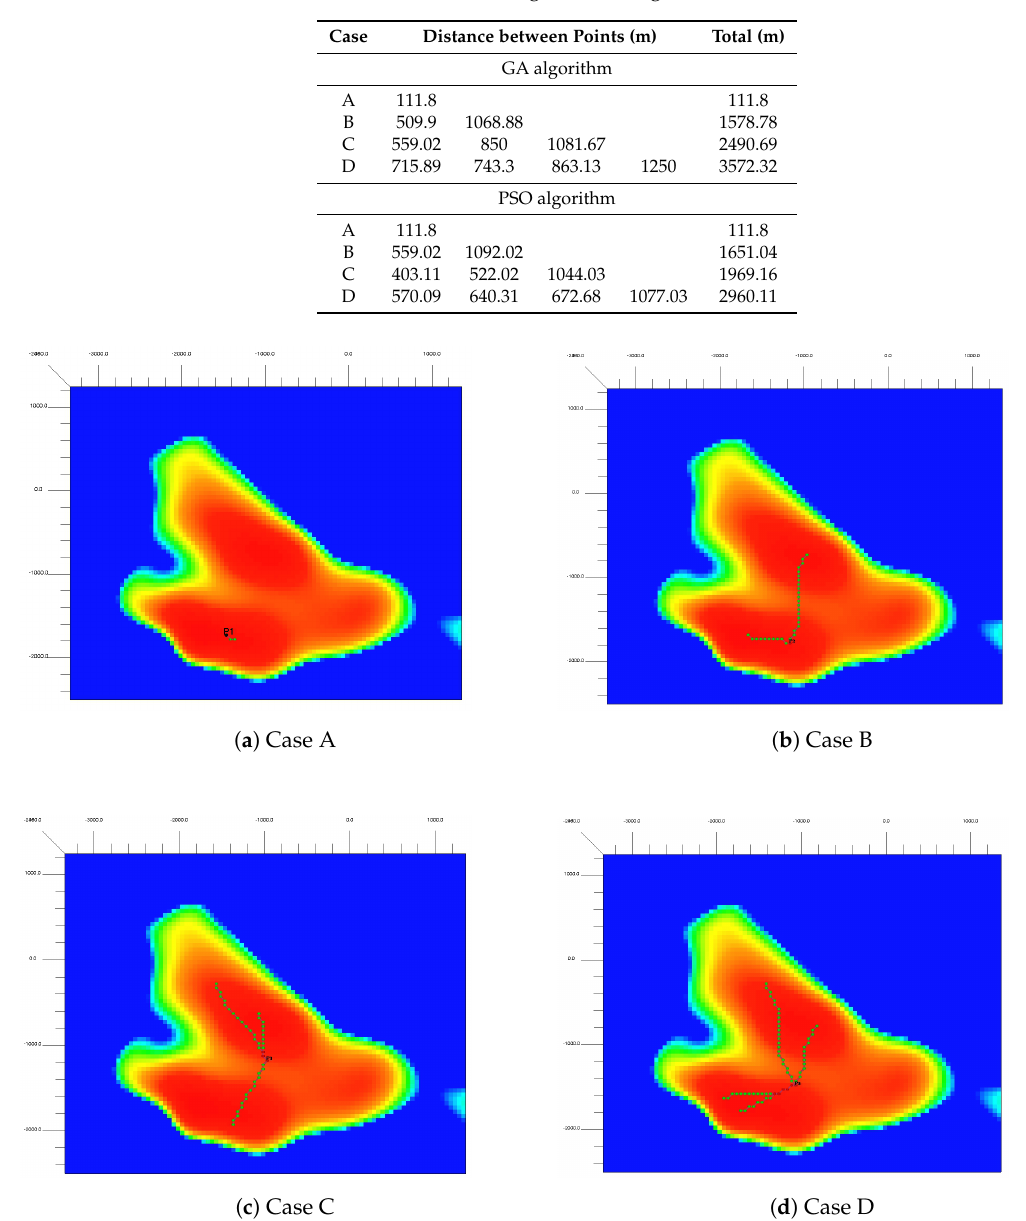
Table 6. Multilateral well length including individual branches.